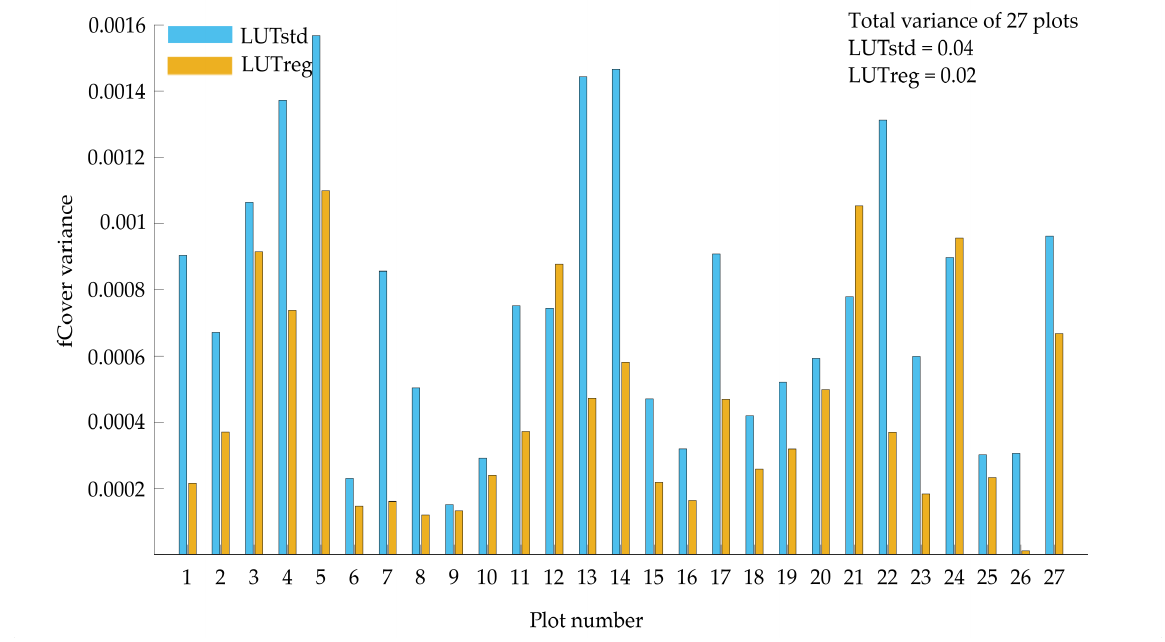
Figure 9. The magnitude of fCover variation across 27 potato plots obtained from both types of